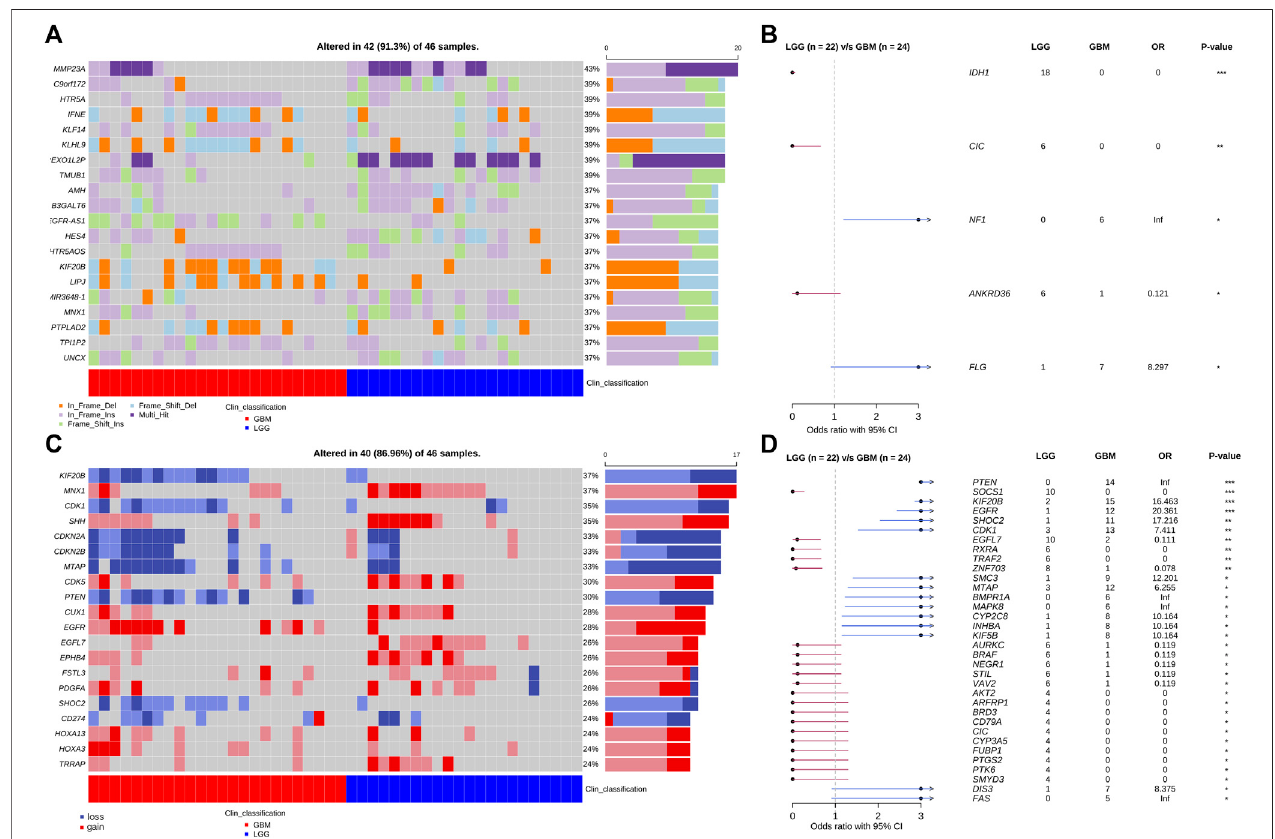
FIGURE 4 | Somatic SNV, indel, and CVN mutations of patients obtained from WES analysis. (A) Top 20 genes with the highest SNV/Indel mutation frequency in thepatientcohort. (B) ForestplotofSNVgeneswithsigni fi cantdistributiondifferenceinLGGandGBMpatients. (C) Top20geneswiththehighestCNVfrequencyinthe patient cohort. (D) Forest plot of CNV genes with signi fi cant distribution difference in LGG and GBM patients. *: p < 0.05; **: p < 0.01; ***: p < 0.001.